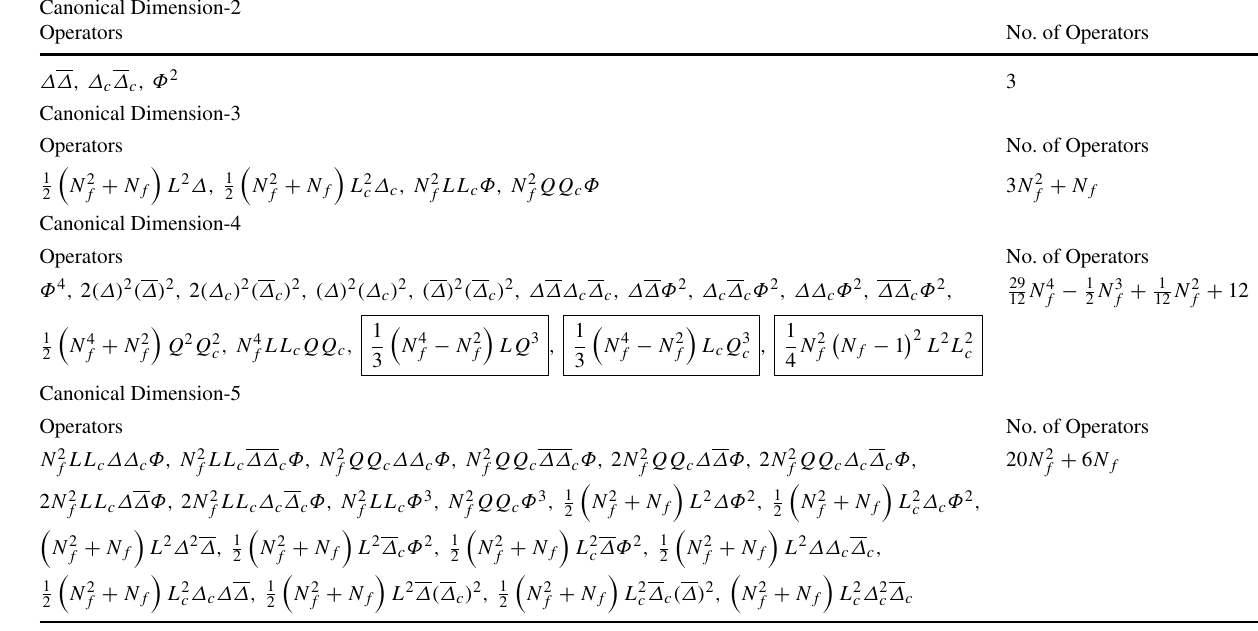
Table 56 Minimal supersymmetric left-right model: operators constituted only of chiral superfields Canonical Dimension-2 Operators